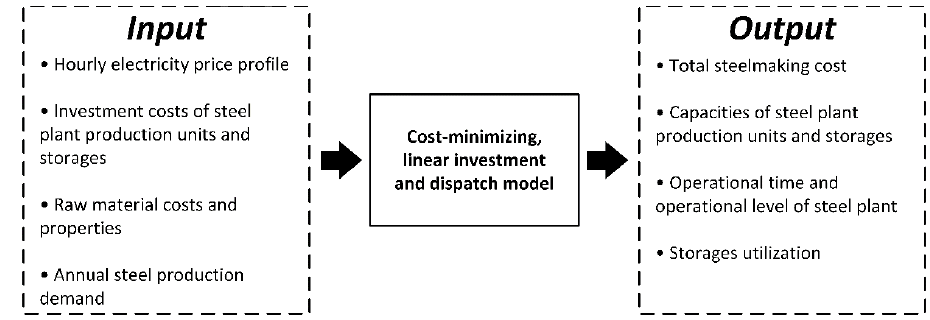
Figure 2. Schematic overview of the model structure applied in this work.